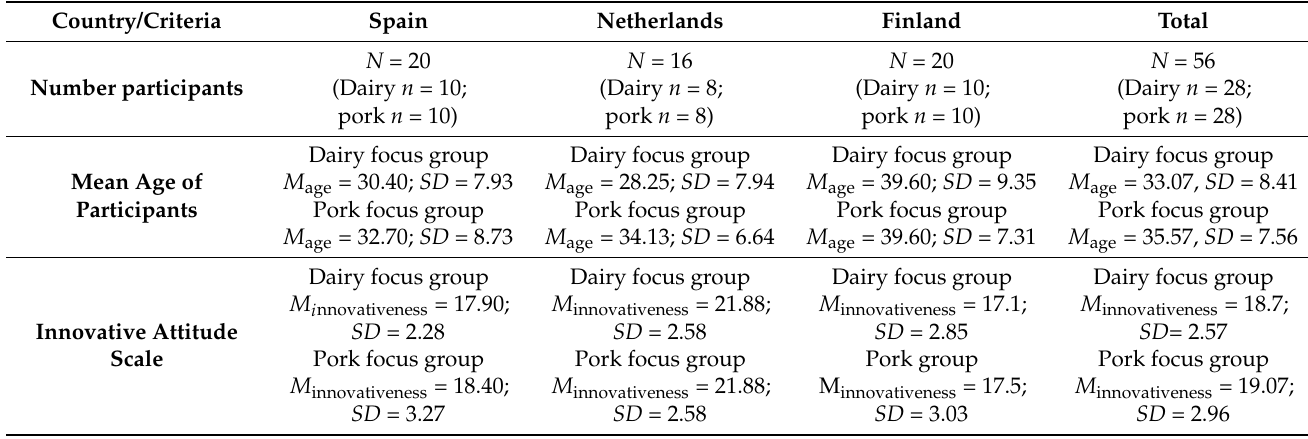
Table 1. Demographic and psycho-social characteristics of the consumers participating in the focus groups conducted in Spain, The Netherlands and